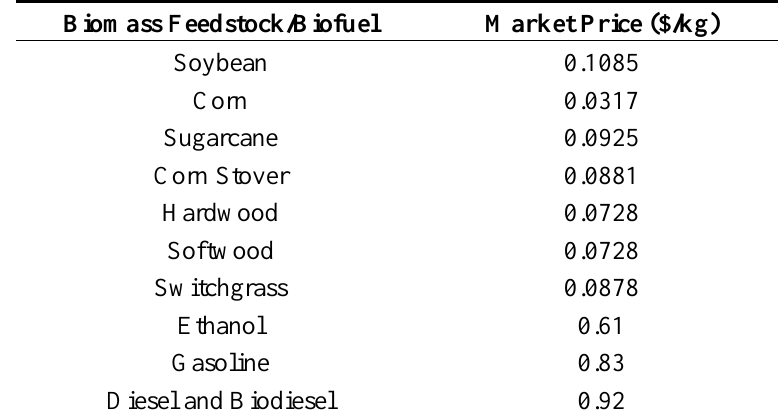
Table 2. Market prices of all raw materials (biomass feedstocks) and products (biofuels) available in this